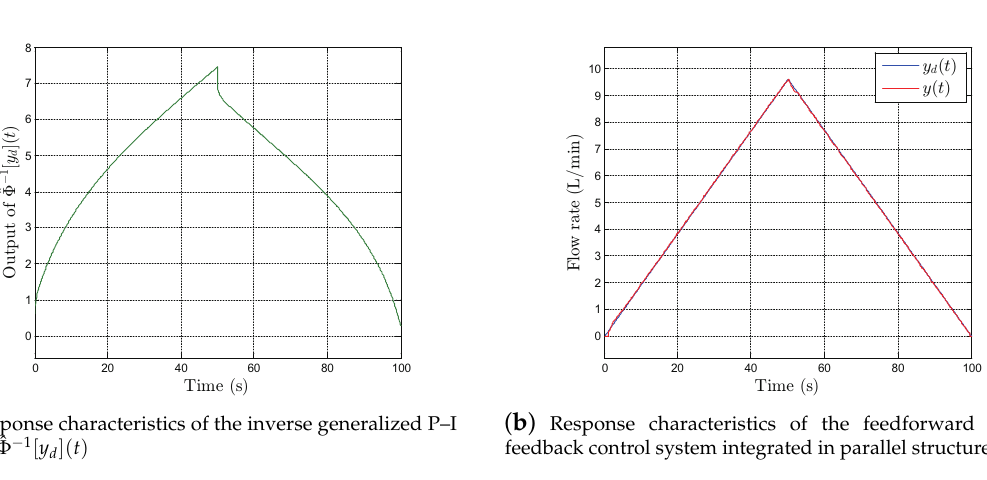
Figure 16. Experimental results of the feedforward plus feedback control system integrated in parallel